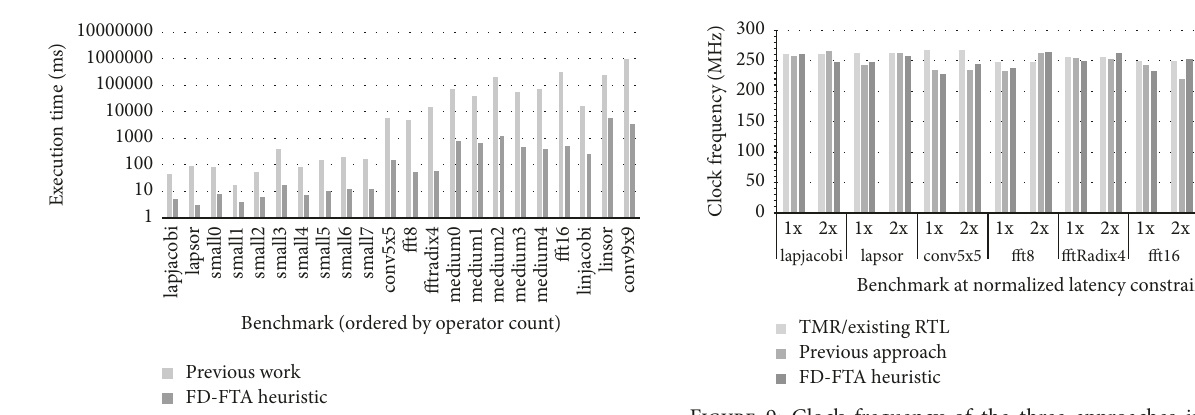
Figure8:Executiontimesofthethreeapproachesinthebenchmark set under a 2x normalized latency constraint and a 100% EC constraint.